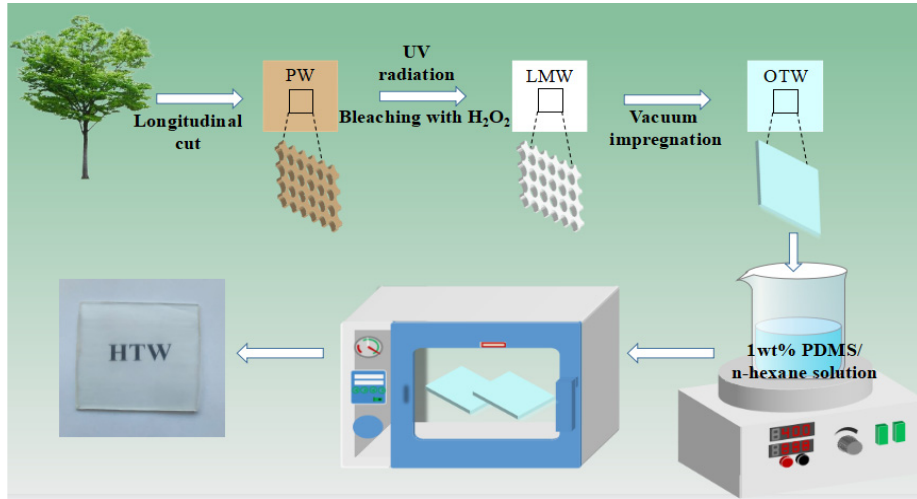
Figure 1. Schematic diagram for the preparation of UV-assisted, hydrophobic, optically transparent